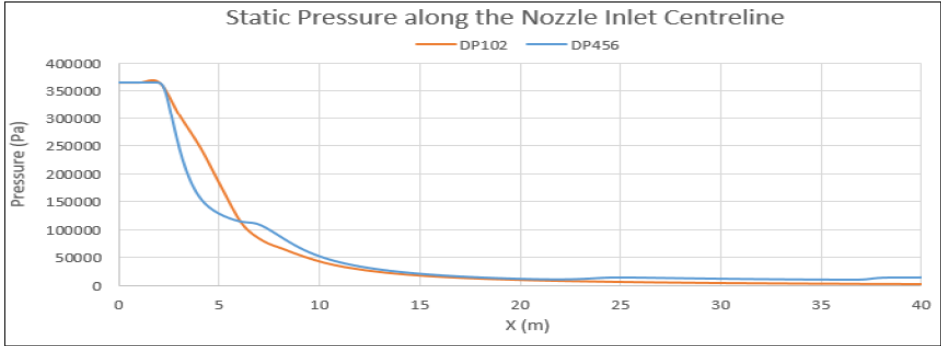
Figure 15. Static pressure of DP102 and DP456 along the nozzle inlet centerline.